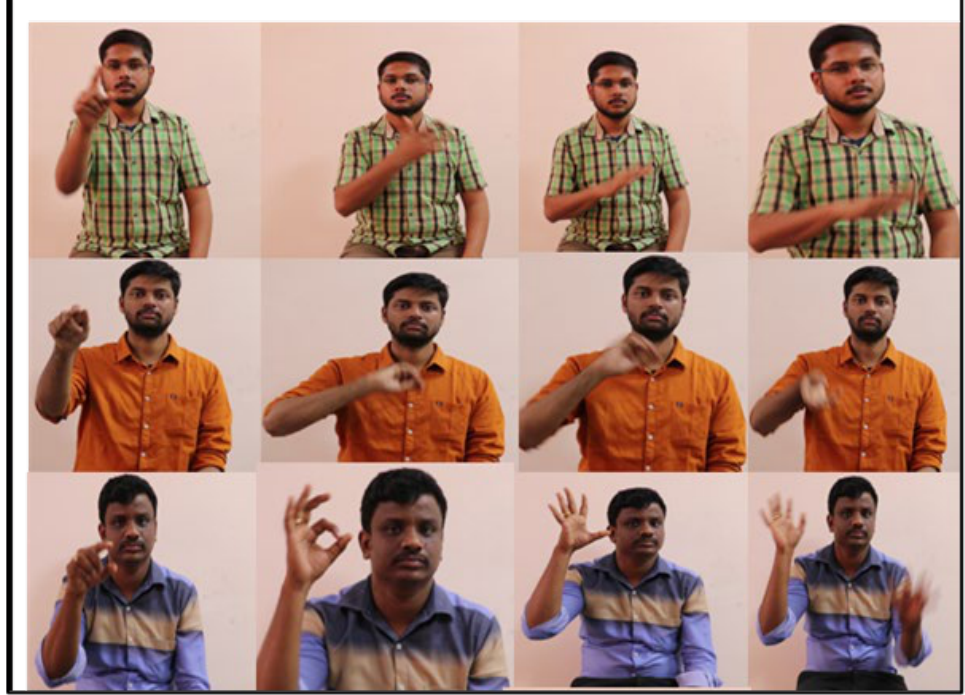
Figure 6. INCLUDE dataset snippet: dataset with multiple signers and signing speeds.